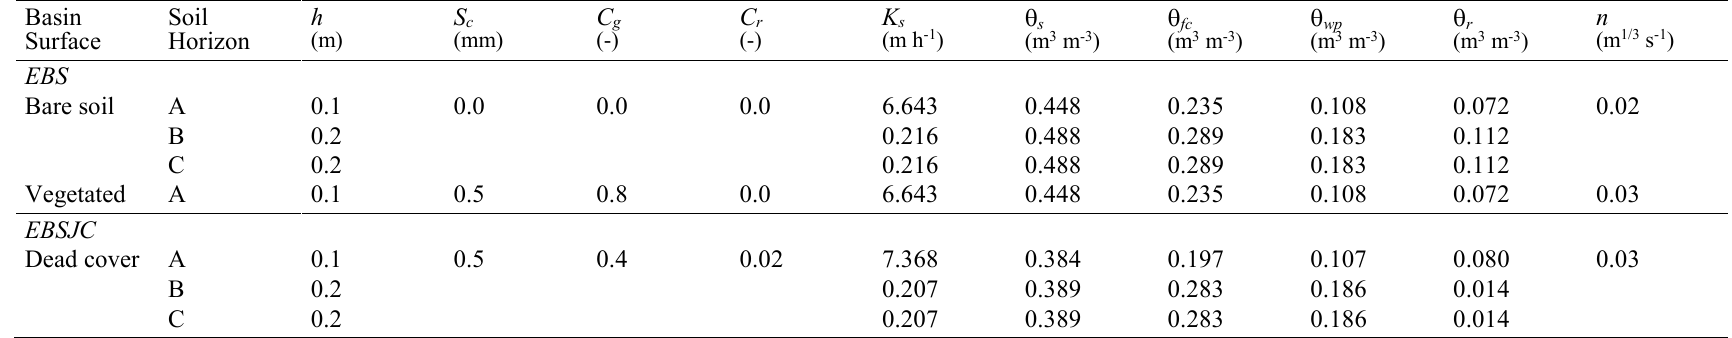
Table 1a Parameter values for the EBS and EBSJC micro-basins. Basin Surface